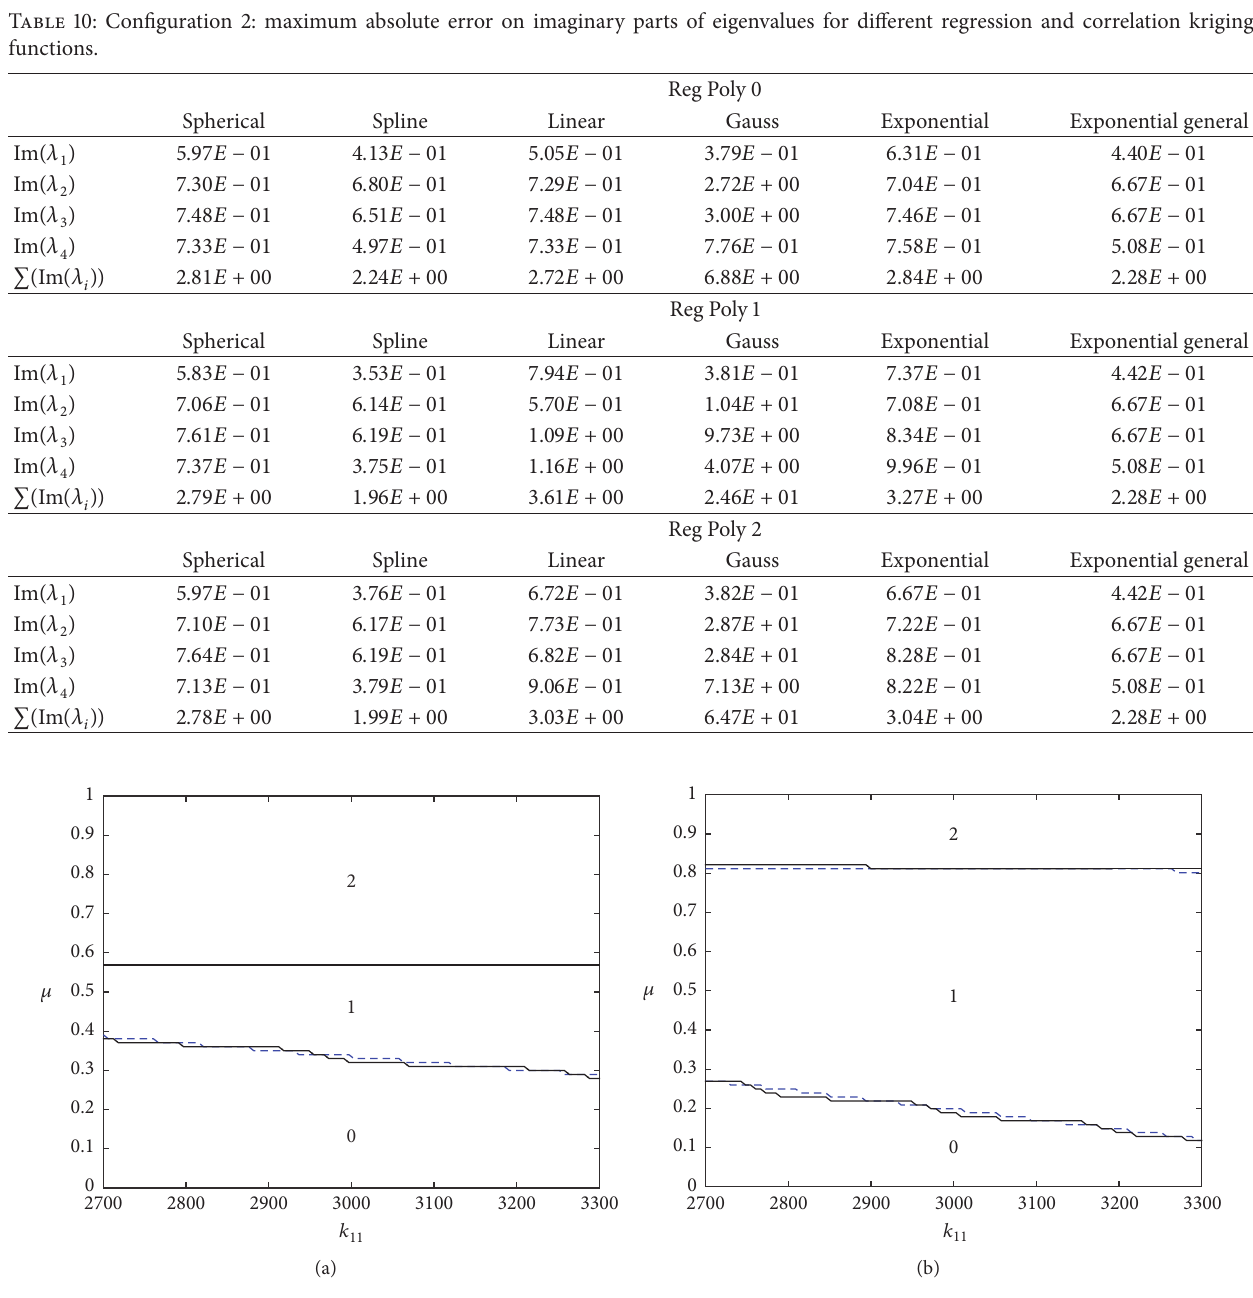
Figure 7: Number of unstable modes versus 𝜇 and 𝑘 11 for configurations 1 (a) and 2 (b): kriging with a 2D linear grid ( − ) and deterministic results